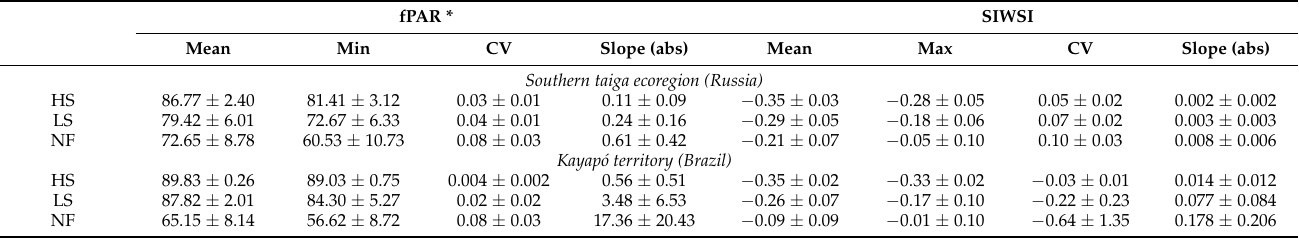
Figure 3. ( a ) Dendrogram based on Ward’s hierarchical clustering showing the reclassification into three forest stability classes of the k -means output (30 clusters) for Kayapó territory (Amazon basin, Brazil). The heat map shows normalized values for each classificatory variable based on transformed data scaled in a 0–100 interval. Brown and green colors in the columns correspond to low and high values, respectively. The horizontal scale on the dendrogram represents the distance or dissimilarity between the clusters. ( b ) Principal component analysis of eight classificatory variables based on fPAR and SIWSI metrics performed on mean values of 30 clusters ( k -means) for Kayapó territory. (Upper panel) Scores of the 30 clusters classified in three ecosystem stability groups, where colors indicate different groups, as in ( a ). Bubble size is proportional to pixel number of each cluster. (Lower panel) Biplot showing the loadings of the first and second principal components (PC1 and PC2) for each variable; the circle denotes perfect representation of variables in the two-dimensional space. Table 1. Mean (±SD) values of variables derived from the fraction of photosynthetically active radiation intercepted by sunlit vegetation canopy (fPAR) and the shortwave infrared water stress index (SIWSI) across different forest stability classes for southern taiga ecoregion (Siberia, Russia) and Kayapó territory (Amazon basin, Brazil). The values were obtained from mean June–August fPAR and SIWSI values over the period 2003–2018. Slope (abs) denotes absolute slope values indicative of the presence or absence of temporal trends for both metrics. HS = high-stability forests; LS = low-stability forests; NF = non-forest areas.